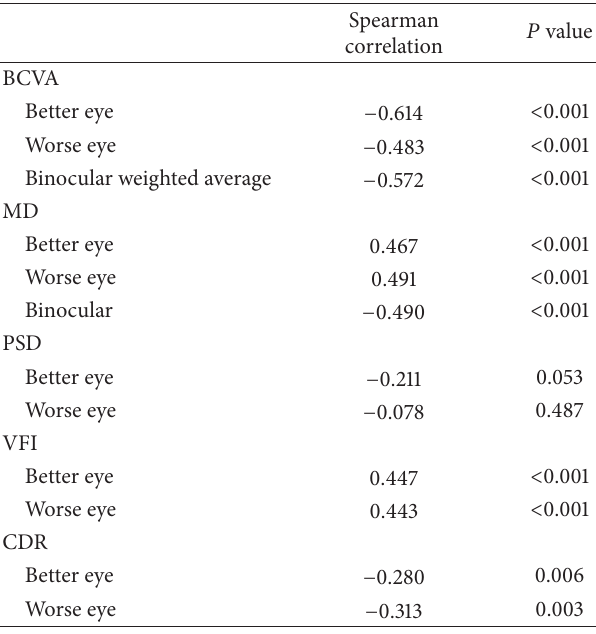
Table 2: Correlation between Chinese-version low vision quality of life (CLVQOL) questionnaire score and visual severity score.